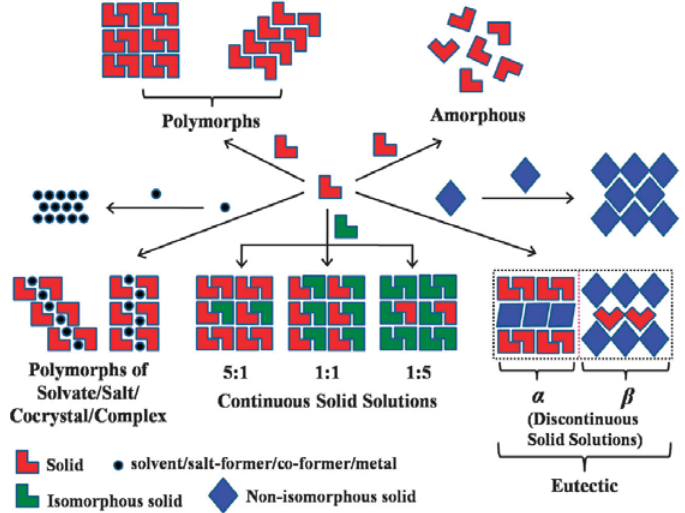
Figure 2. Schematic representation of various single and multicomponent forms of an API [Reprinted from [34] with permission. Copyright 2014 Royal Society of Chemistry].